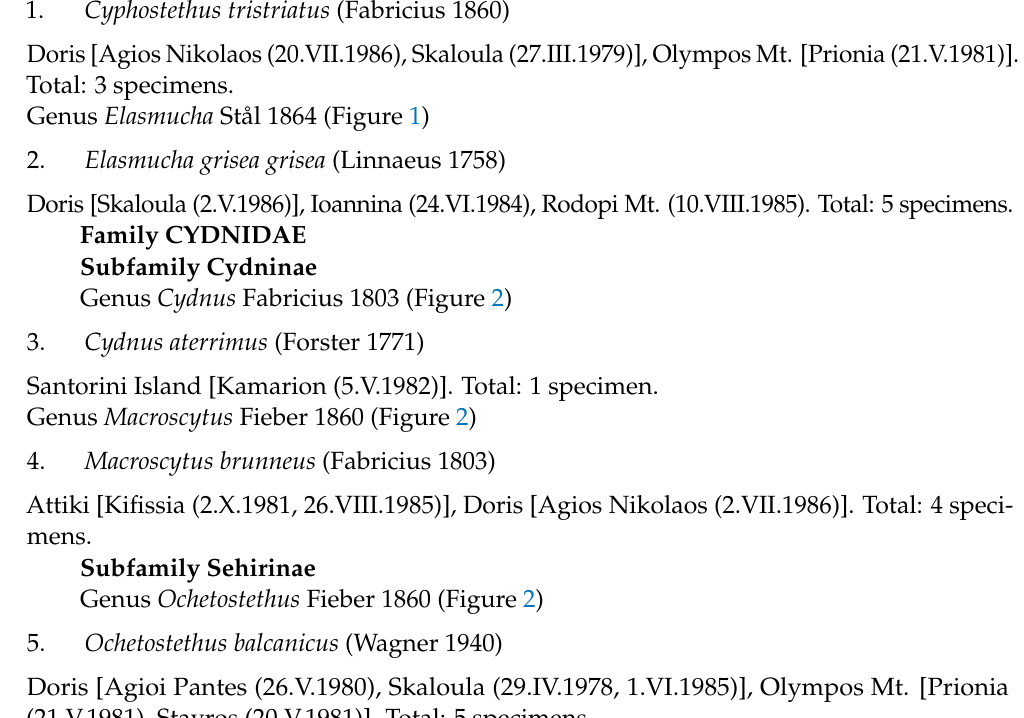
Figure 1. Map showing collecting sites of species of genera Cyphostethus and Elasmucha during the present study in Greece (AL = Albania, NM = North Macedonia, BG = Bulgaria, TR = Turkey).